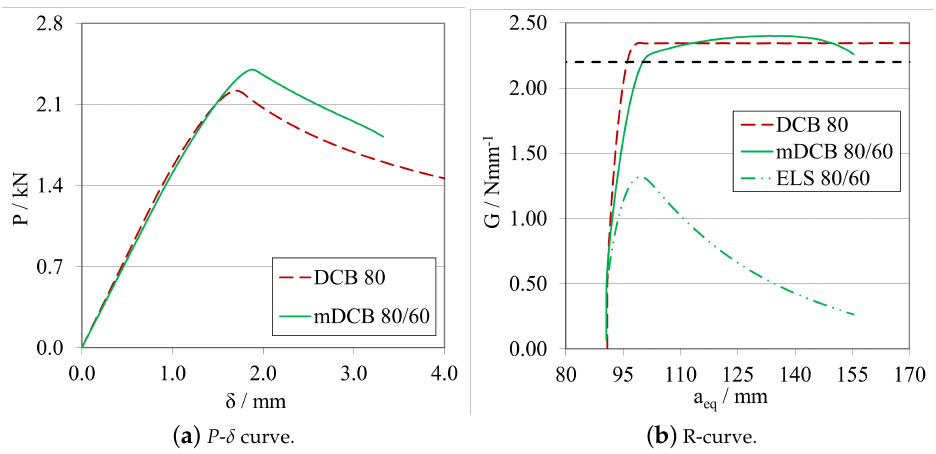
Figure 28. Curves related to the mDCB test of a generic flexible/tough structural adhesive, against the correspondent standard DCB, analysed through the novel mDCB CBBM data reduction scheme. Black dashed line in ( b ) represents the input G IC